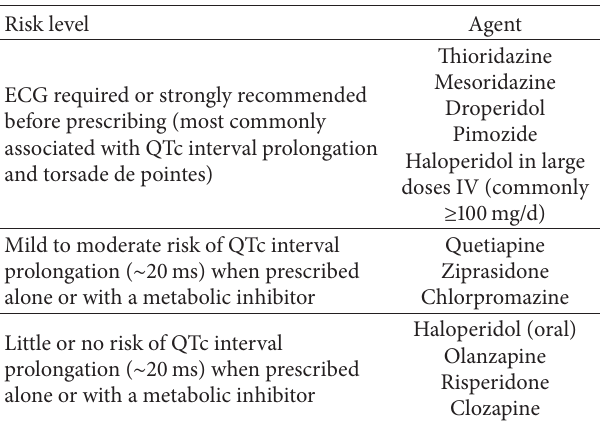
Table 6: Relative risk of QTc interval prolongation with common antipsychotic